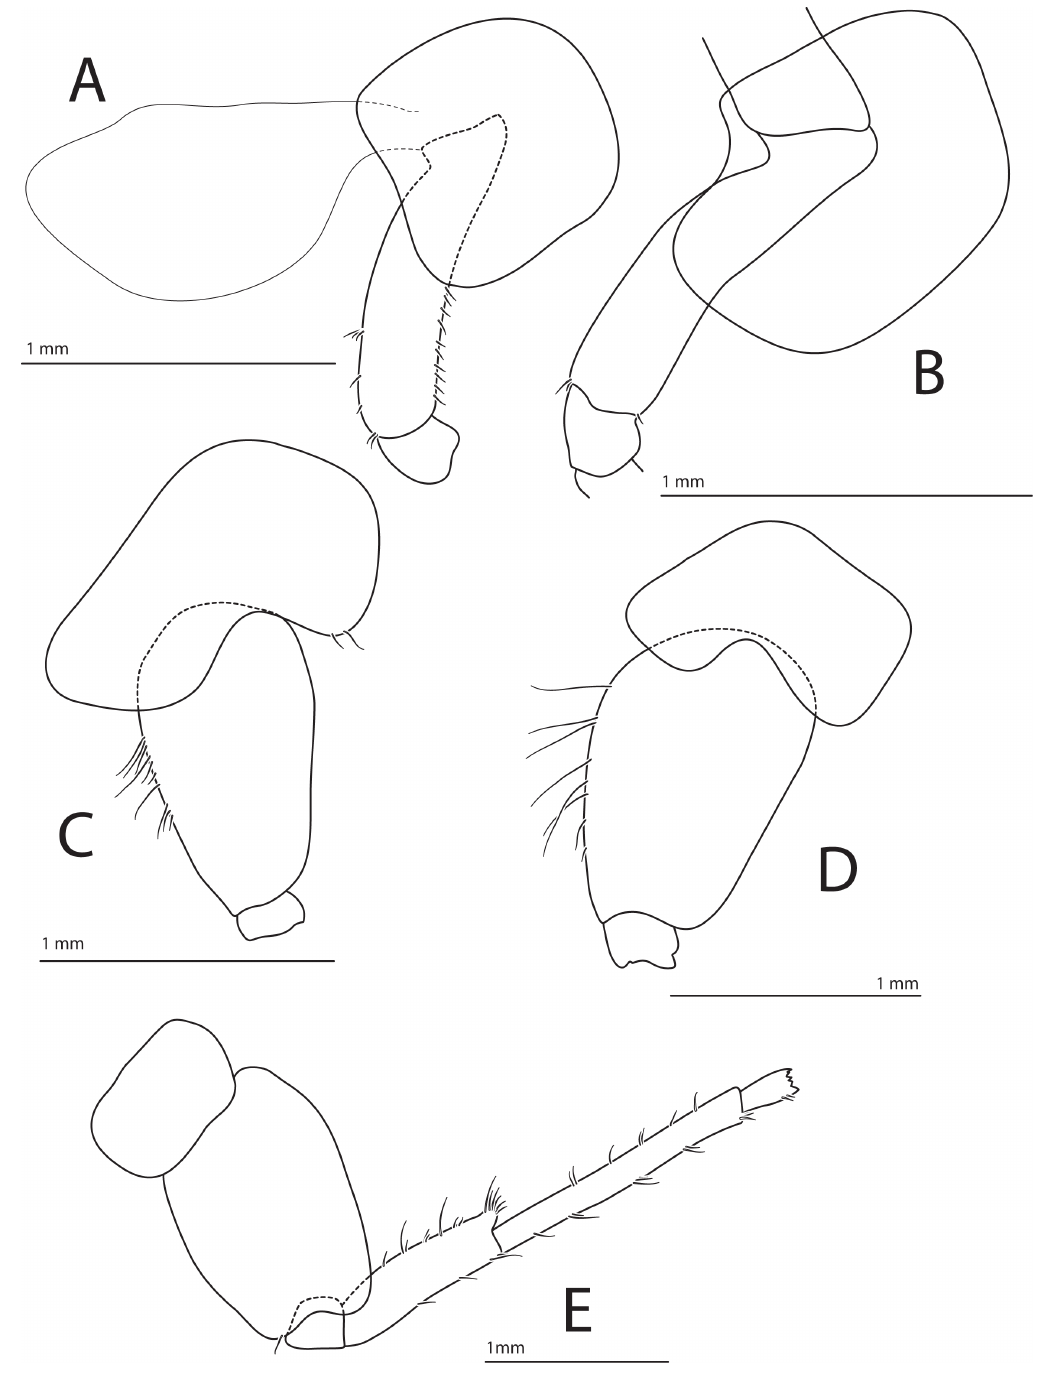
Fig. 6. Halirages helgae sp. nov. A – D . Holotype, ♀ , 10 mm long. A . Pereiopod 3. B . Pereiopod 4. C . P ereiopod 5. D . Pereiopod 6. — E . Paratype 2, ♀ , 9 mm long. Pereiopod